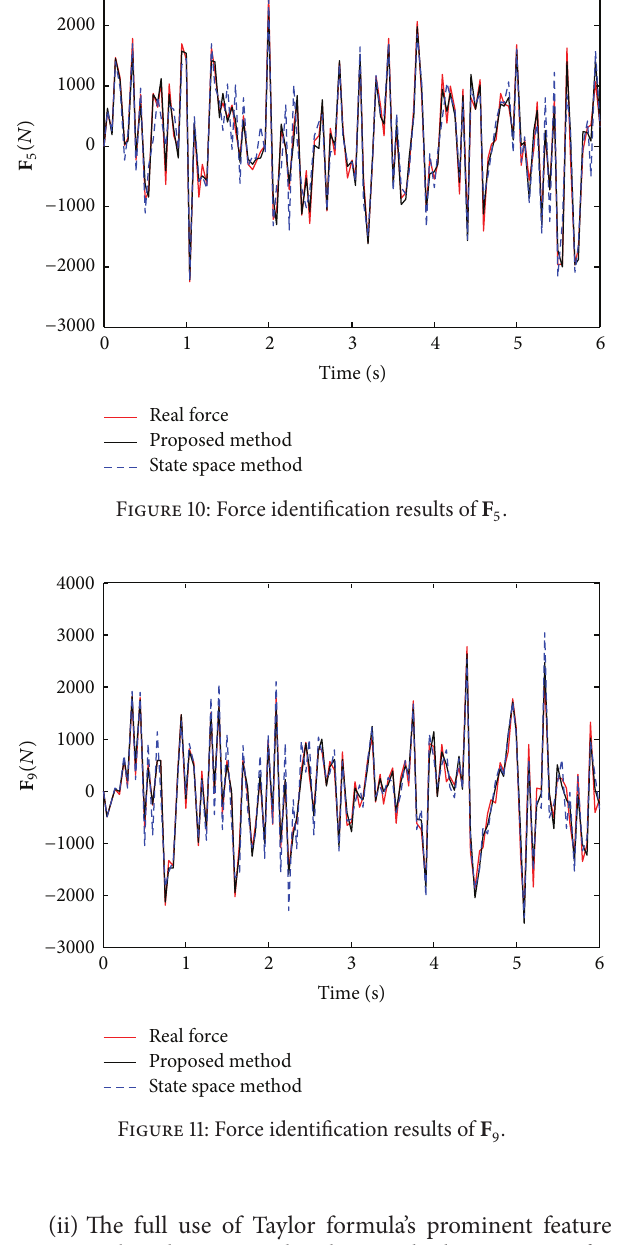
(ii) The full use of Taylor formula’s prominent feature makes this approach achieve a higher accuracy for the identification of sinusoidal excitation and white noise excitation. The more complex the load form is, the more obvious superiority of the new method becomes. (iii) The identification results are satisfactory when the noise is taken into the responses, which indicates a lower noise